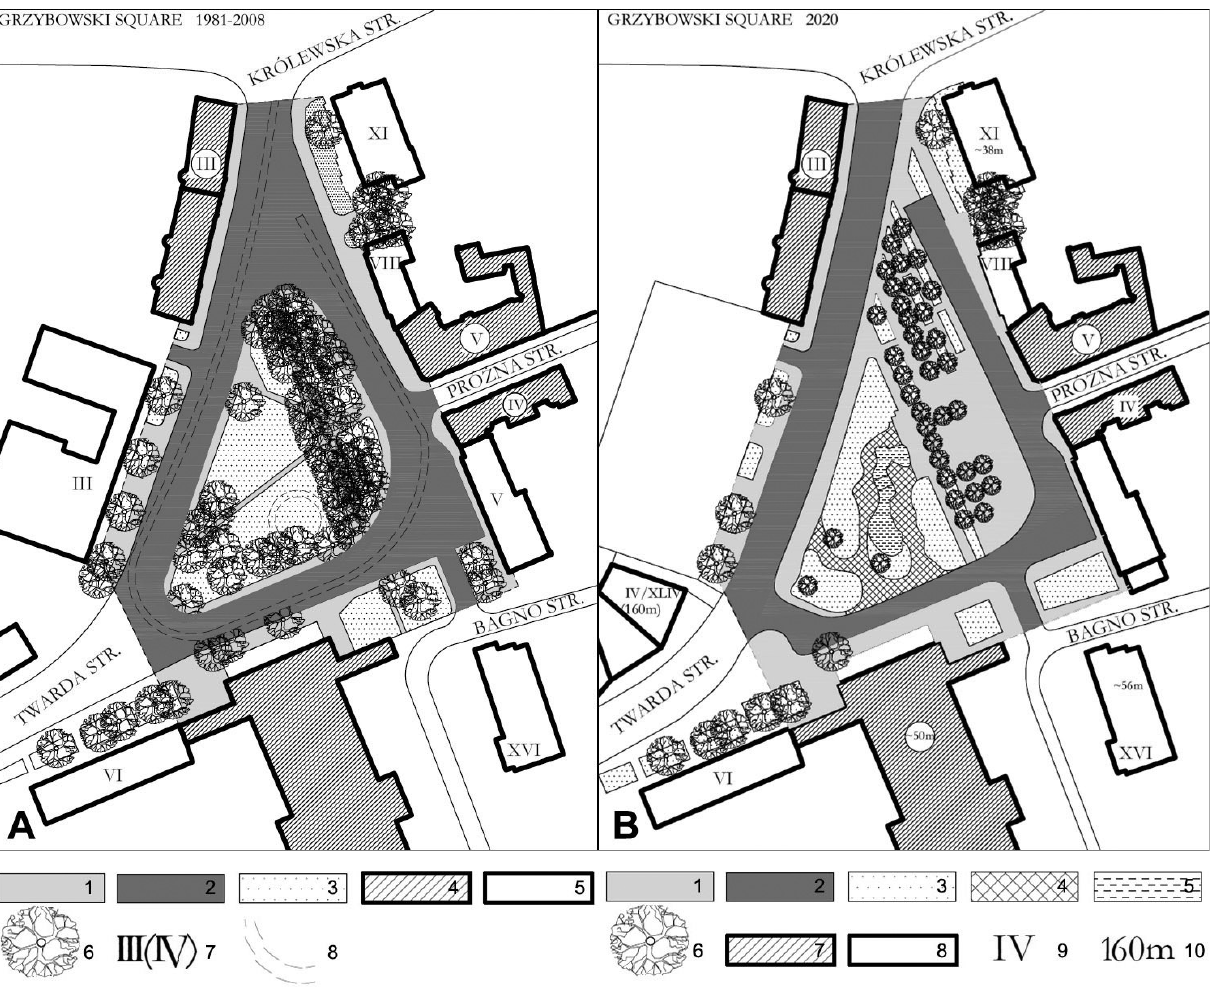
Figure 2. Grzybowski Square. A) 1981–2008. Legend: 1. Pavement/concrete slabs, 2. Roadways and parking (tarmac), 3. Lawns, 4. Pre‐war buildings, 5. Buildings since 1945, 6. Trees, 7. Number of floors (overbuilt), 8. Oxygenerator 2007, and 9. Unused tramway tracks; B) 2020. Legend: 1. Pavement, 2. Roadways and parking (tarmac), 3. Lawns, 4. Permeable surface, 5. Water surface, 6. Trees, 7. Pre‐war buildings, 8. Buildings since 1945, 9. Number of floors, and 10. Maximum building